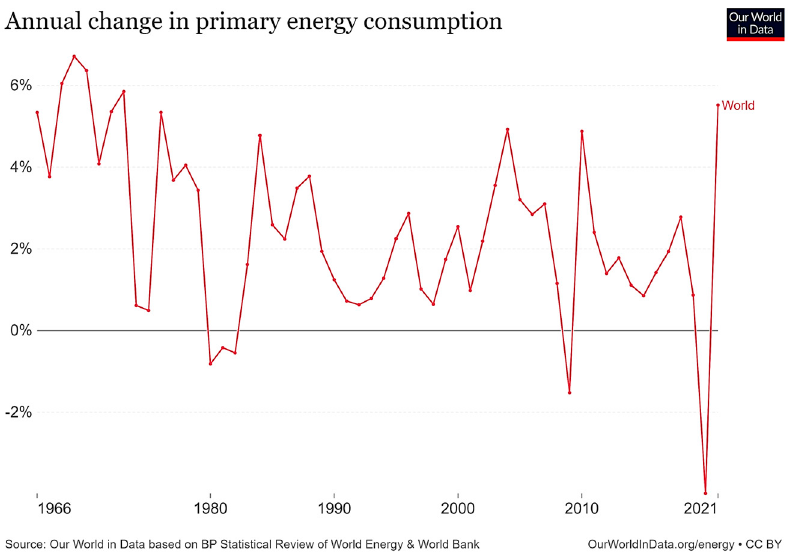
Figure 1. Global primary energy consumption change (the change is expressed as a percentage of the previous year’s consumption) [1].